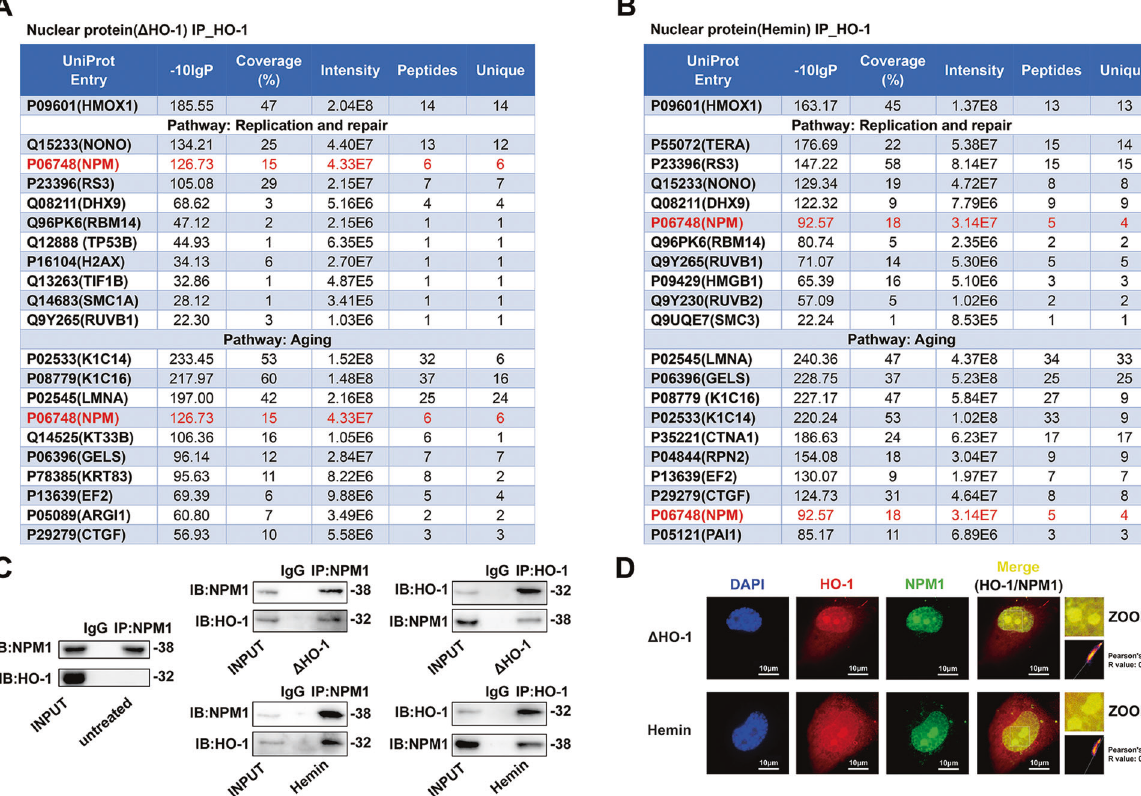
Fig. 5 Nuclear HO-1 interacted with NPM1 in the nucleolus and nucleoplasm. A IP-MS screening analysis in “ Aging ” and “ DNA replication and repair ” pathways (HUVECs were transfected with Δ HO-1). B IP-MS screening analysis in “ Aging ” and “ DNA replication and repair ” pathways (HUVECs were stimulated by Hemin). C HO-1 interacted with NPM1 directly in HUVECs in the presence of Δ HO-1 or Hemin, but not in untreated cells. n = 3. D HO-1 colocalized with NPM1 in the nucleolus and nucleoplasm. n = 3. Colocalization 2D intensity histogram and Pearson ’ s R value were analysed by the Fiji ’ s plugin Coloc 2